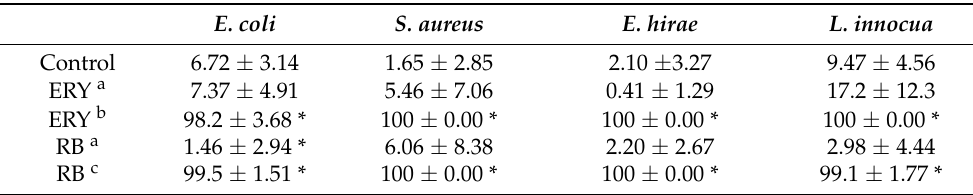
Table 4. Percentage of biofilm cells stained with propidium